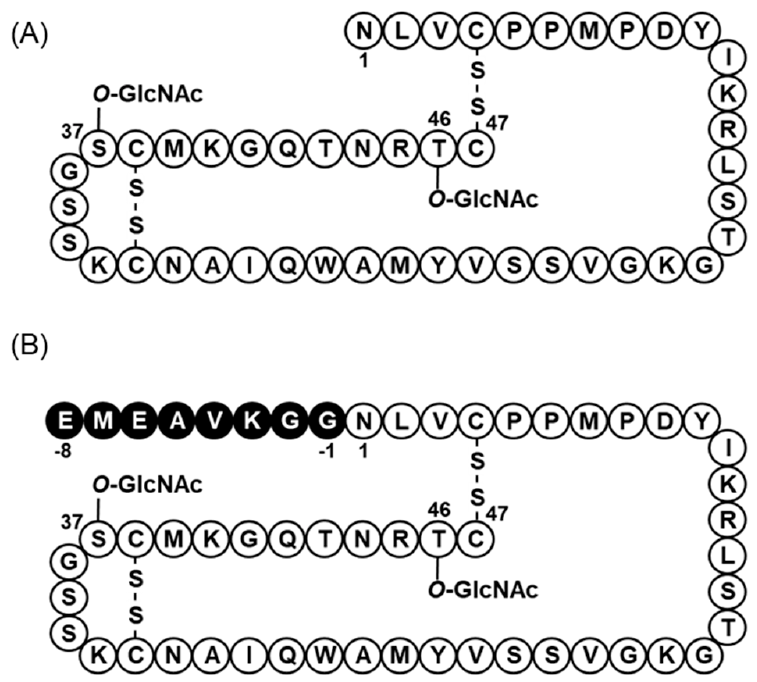
Figure 3. Structures of enterocin F4-9 and the long peptide. Original enterocin F4-9 ( A ) was produced by E . faecalis F4-9, and the long peptide ( B ) was produced by E . faecalis JH2-2 harboring pF49-TABCI. Eight amino acid residues indicated by black in the N-terminal represent the elongated se- quence.